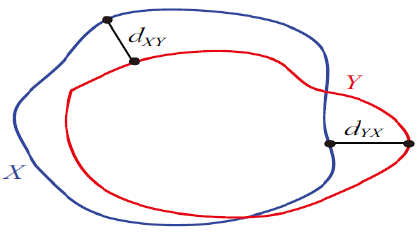
Figure 6. Hausdorff distance. Here, sup is the least upper bound, inf is the greatest lower bound, and d is the Euclidean matrix.